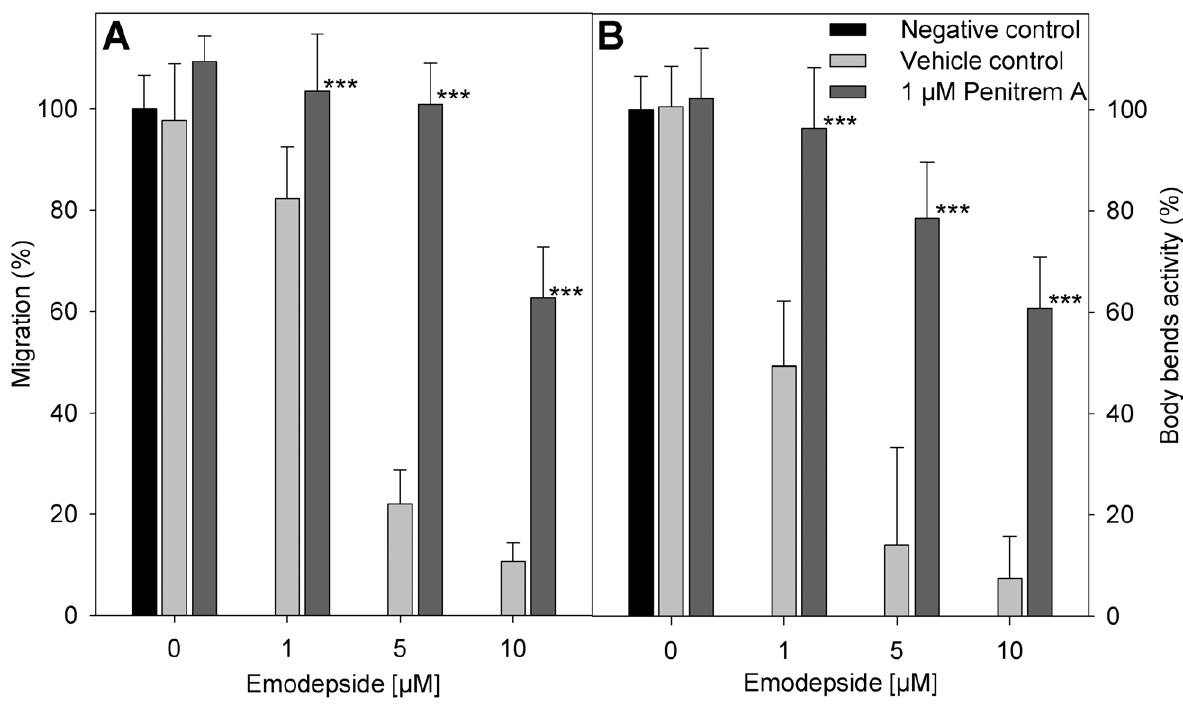
Figure 5. Effect of penitrem A and emodepside on nematode locomotion. (A) Migration of infective A. caninum larvae (relative to negative control without vehicle) through a 20 m m precision sieve after incubation in different concentrations of emodepside in presence or absence of penitrem A. (B) Body bend activity of C. elegans (relative to negative control without vehicle). (A, B) Negative control (black bar), without vehicle or substance; vehicle control (light grey bars), with 28 mM DMSO, 170 mM ethanol, and the indicated emodepside concentrations; 1 m M penitrem A (dark grey bars), with 1 m M penitrem A, 170 mM ethanol and the indicated emodepside concentrations. Error bars represent standard deviations. Asterisks mark a significant difference between vehicle controls and the experiments with 1 m M penitrem A at the same emodepside concentration (*** p , 0.001) determined by One-Way-ANOVA followed by a Tukey’s pairwise comparison.